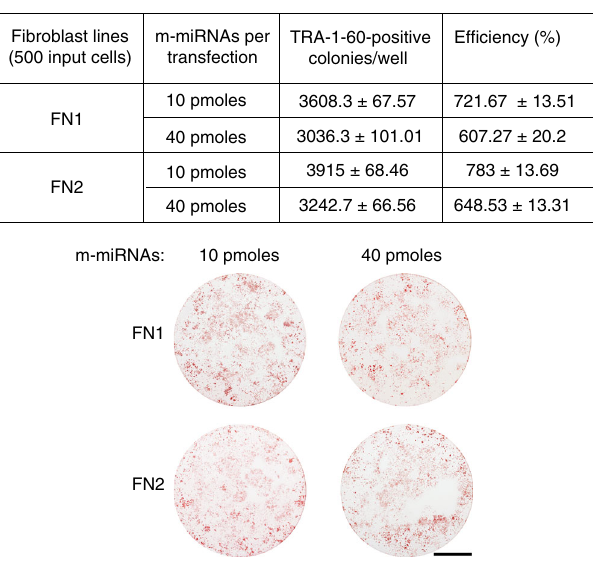
Fig. 3 The ef fi ciency of the RNA-based reprogramming approach using different m-miRNA concentrations. Summary table and representative TRA-1-60-stained reprogramming wells show the yield of TRA-1-60- positive colonies at day 18 of the optimized RNA-based reprogramming regimen (Fig. 1b) performed with differing amounts of m-miRNAs as indicated. The protocol was initiated with two independent human primary neonatal fi broblast lines (FN1 and FN2) plated at a density of 500 cells per well of a 6-well format dish. The reprogramming ef fi ciency was calculated by dividing the number of resulting TRA-1-60-positive colonies by the number of input cells and multiplying by 100%. Mean± s.d. ( n = 3).